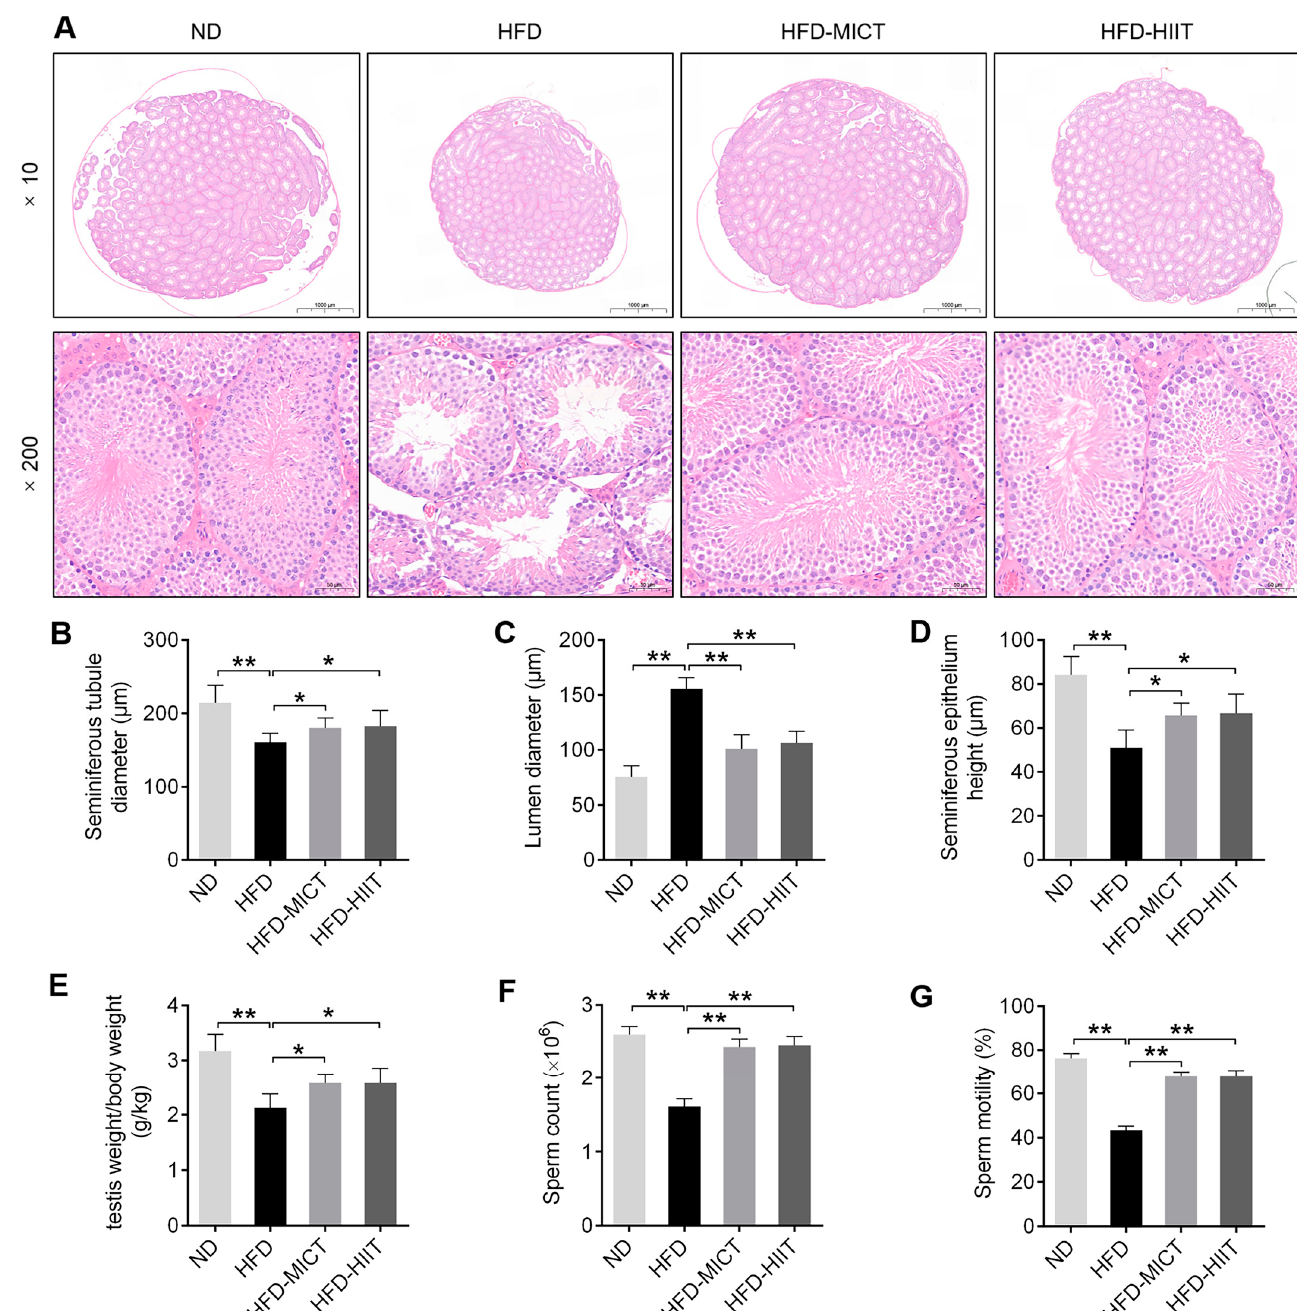
Figure 2. Effects of MICT and HIIT on testicular morphology in obese mice. ( A ) HE staining of mouse testes at 10 × (scale bar = 1000 µ m) and 200 × (scale bar = 50 µ m) magnification. Statistical analysis of ( B ) seminiferous tubule diameter, ( C ) lumen diameter, ( D ) seminiferous epithelium height, ( E ) testis weight/body weight ratio, ( F ) sperm count and ( G ) sperm motility. Data are ex- pressed as mean ± SEM. * p < 0.05, ** p < 0.01.